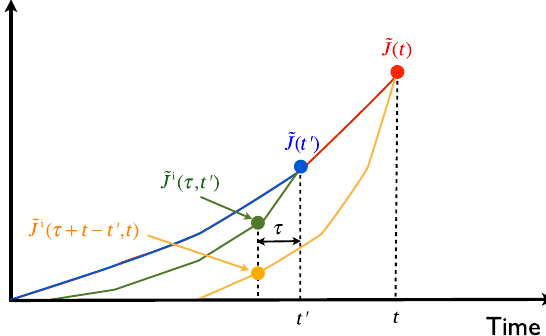
FIG. 6. Dependency of the rate of new infections at time t 0 , ~ J ð t 0 Þ , on the rate of new infections at time t 0 (cid:2) (cid:2) , blue and red curves show the rates of new infections by time t 0 and t , respectively. The green and yellow curves show the fraction of those that remained infectious for at least (cid:2) and (cid:2) þ t (cid:2) t 0 units of time,